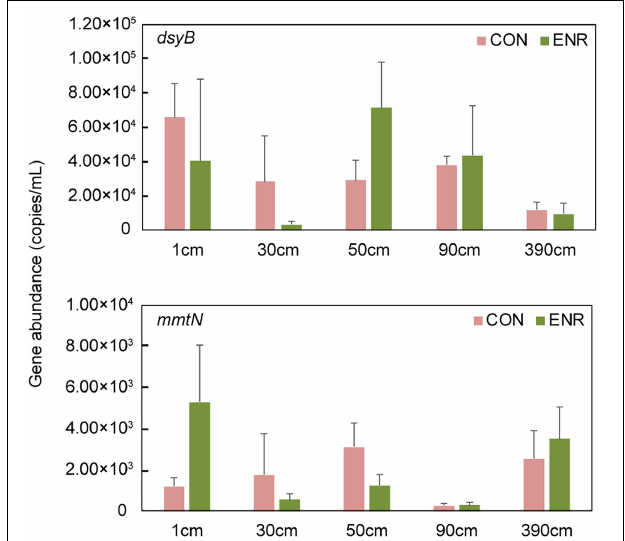
FIGURE 3 | The abundance of dsyB and mmtN in the samples from enrichment incubation. CON, the control group in normal MBM; ENR, the DMSP-enriched groups in modified